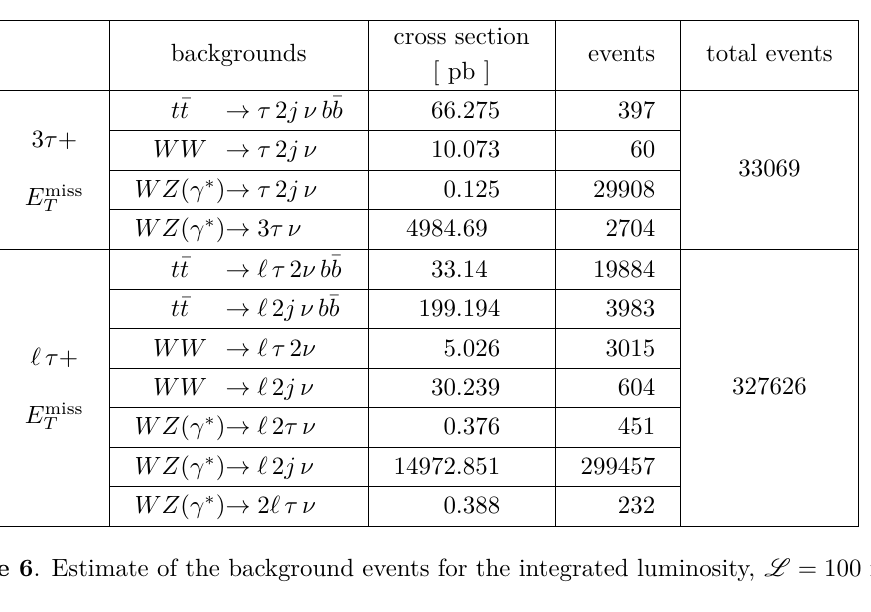
, m χ ) = (120 , 420 , 150) GeV and ( y D ψ ±